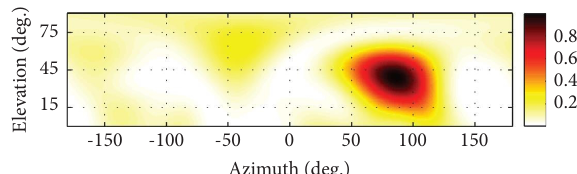
Figure 8: Normalized power pattern: proposed null steering.